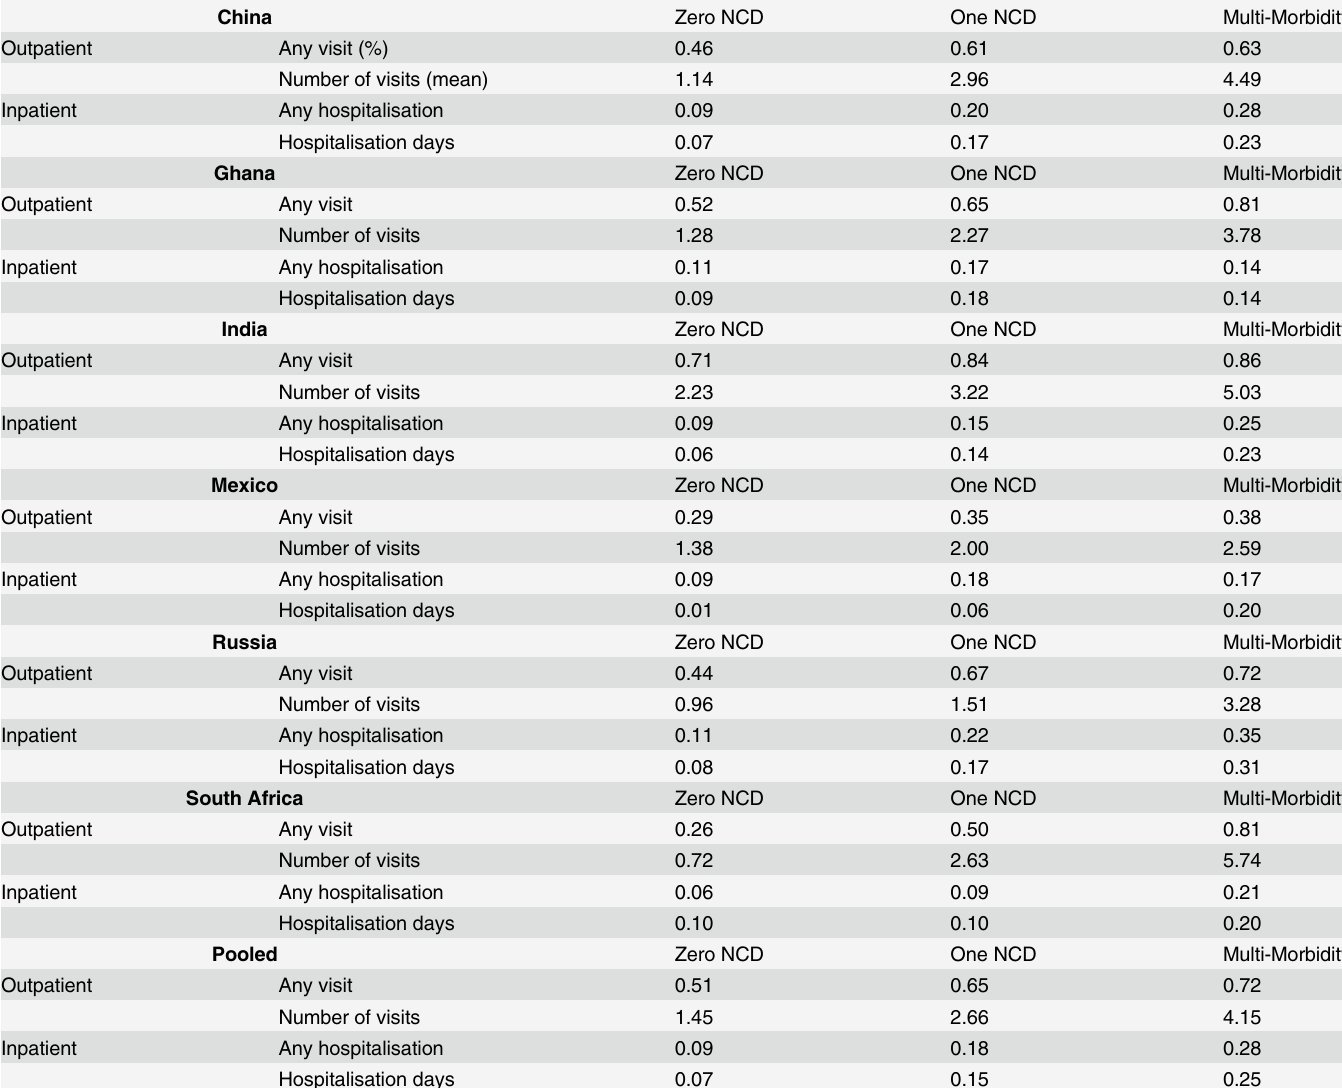
Table 2. Association between number of NCDs and healthcare